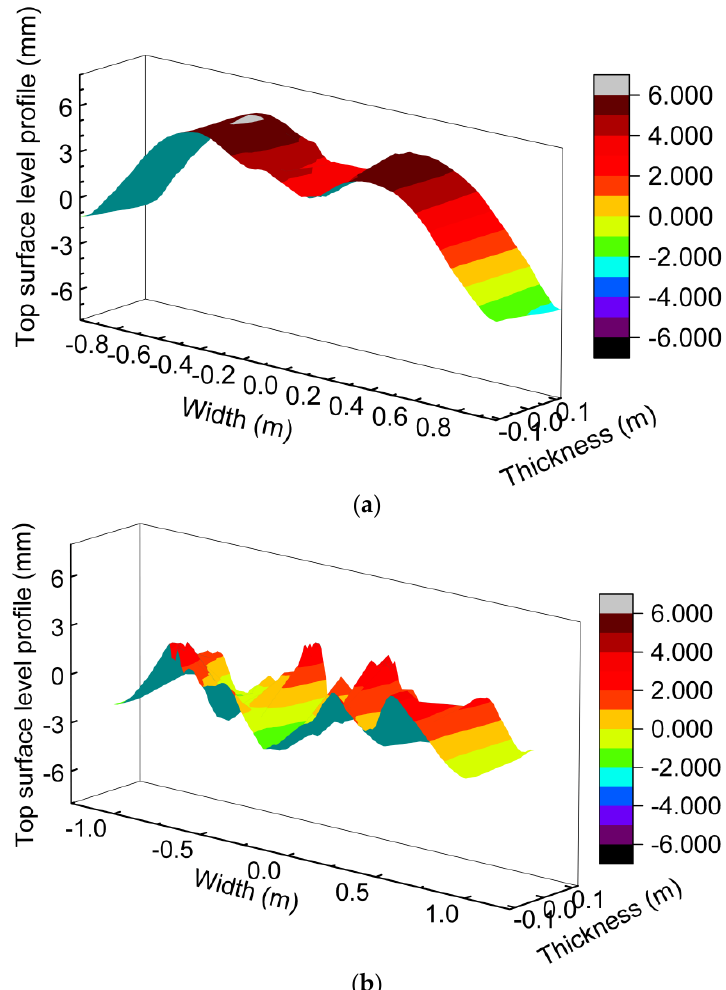
Figure 14. Top surface level profiles of mold with different SEN bottom shapes of ( a ) mountain, ( b ) well.